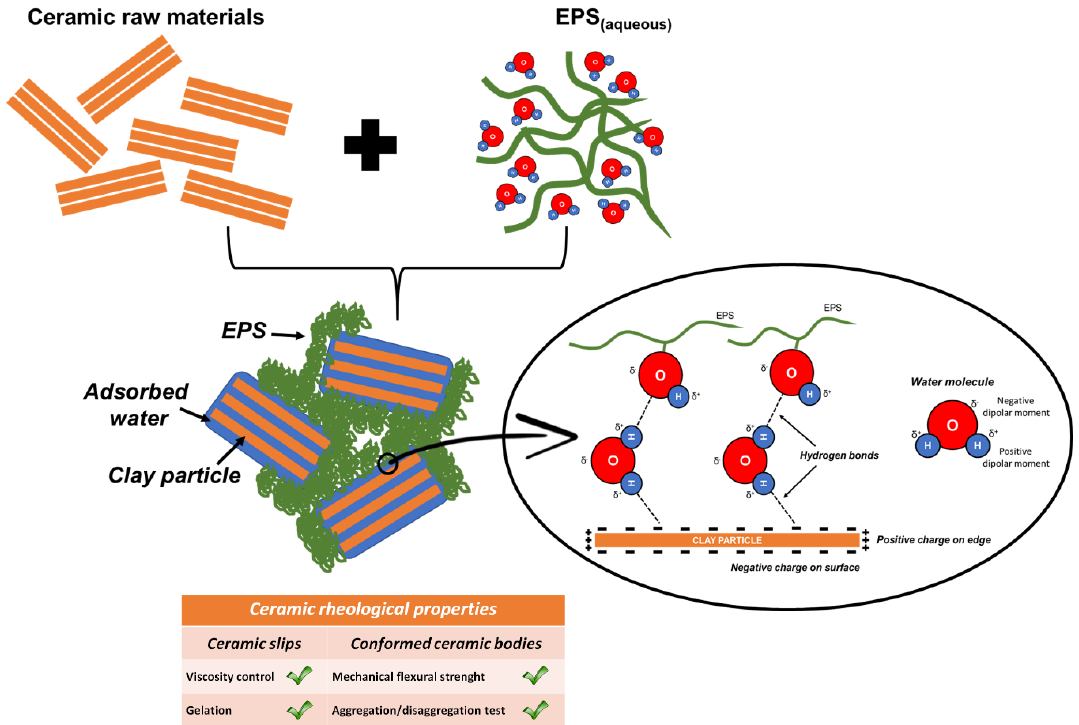
Figure 7. Conceptual model of the e ff ect of adding EPS to ceramic materials and their potential impact on the rheological